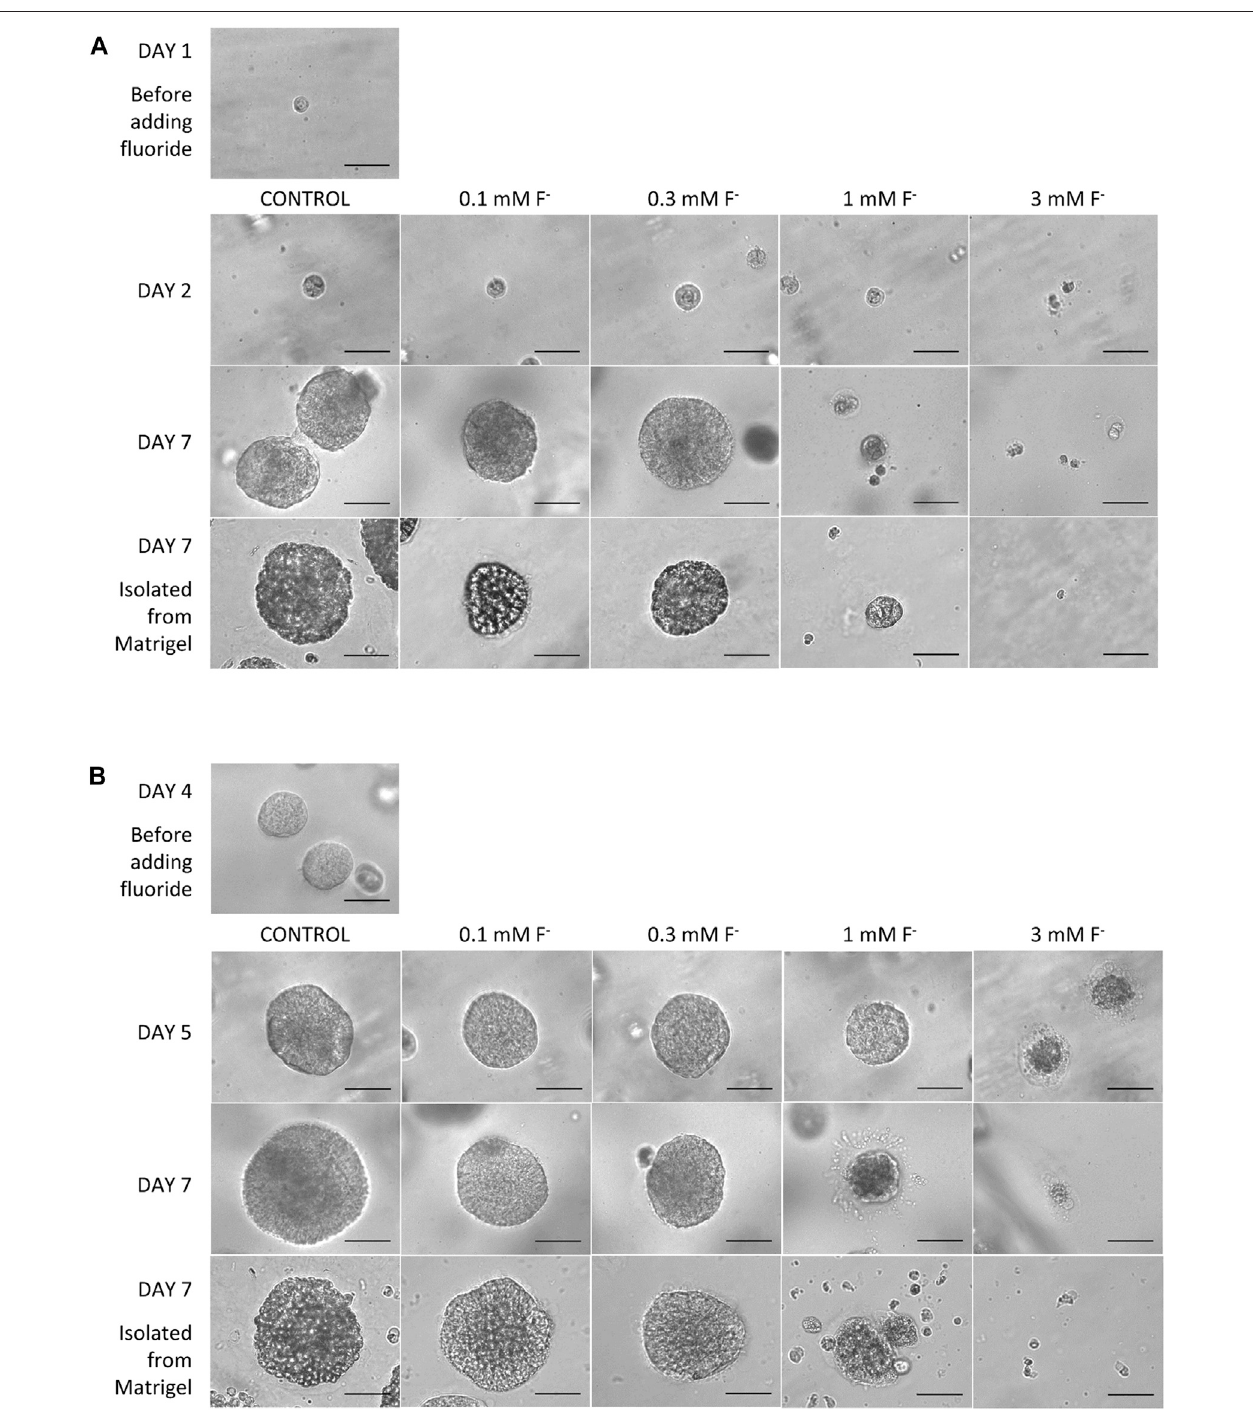
FIGURE 7 | Morphology of HAT-7 spheroids cultured in Matrigel and Hepato-STIM medium in the absence (control) or presence of fl uoride (0.1 – 3.0 mM). (A) Spheroid images obtained on days 1, 2, and 7 when fl uoride (0, 0.1, 0.3, 1.0, 3.0 mM) was added to the culture medium 24 h after seeding. Also shown are spheroids isolated from the Matrigel on day 7. (B) Spheroid images obtained on days 4, 5, and 7 when fl uoride (0, 0.1, 0.3, 1.0, 3.0 mM) was added to the culture medium at the time of rapid spheroid growth 4 days after seeding. Also shown are spheroids isolated from the Matrigel on day 7. Scale bars: 70 µm.